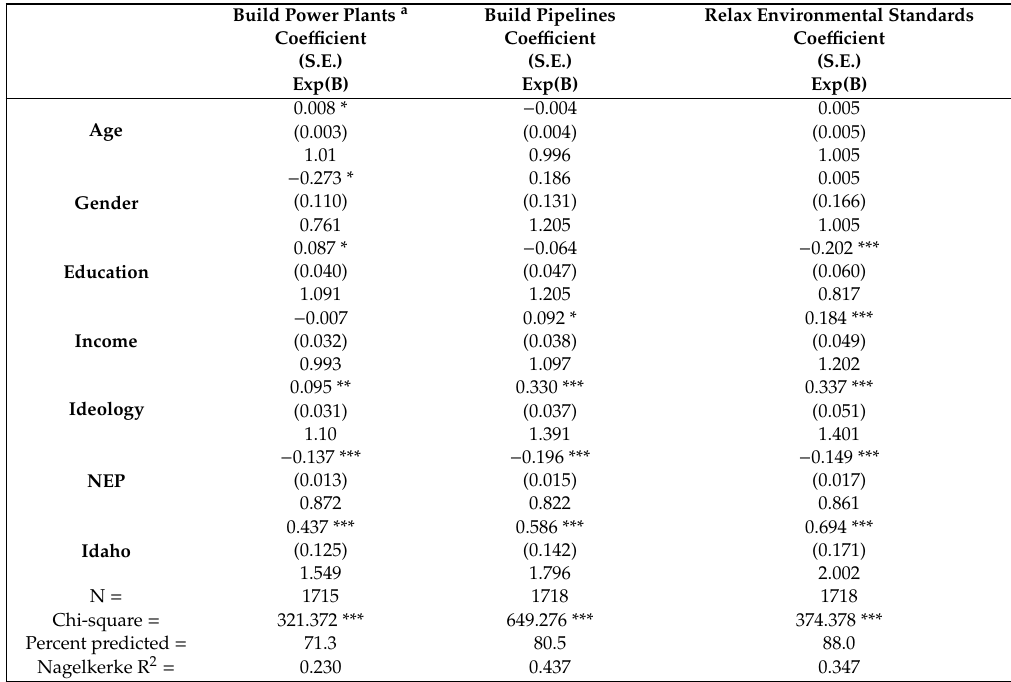
Table 5. Logistic Regression Estimates for Energy Infrastructure